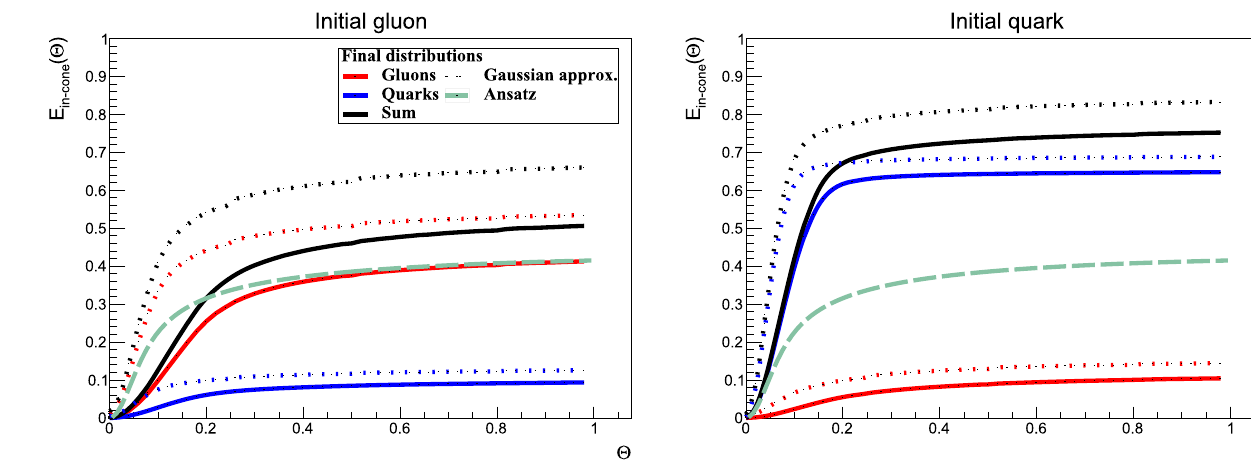
+ l 2 ) ] forthetime-scales t = 0 . 1 , 1 , 2 , 4fm D